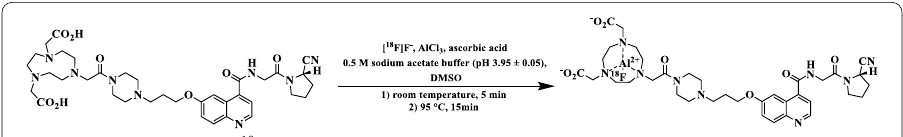
Fig. 3 Reaction schema of [ 18 F]AlF-FAPI-74 with one-pot and one-step